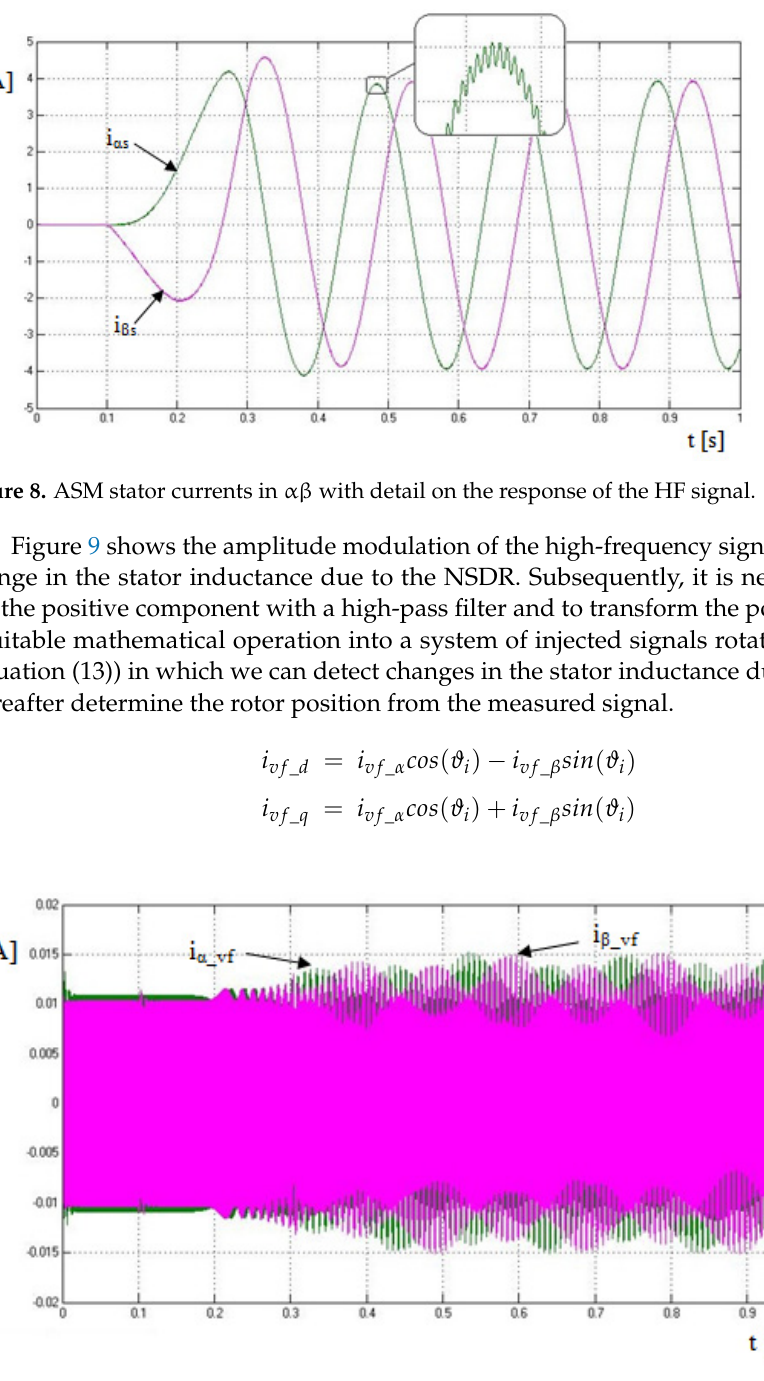
Figure 9. The course of the current response to the HF voltage signal in αβ .